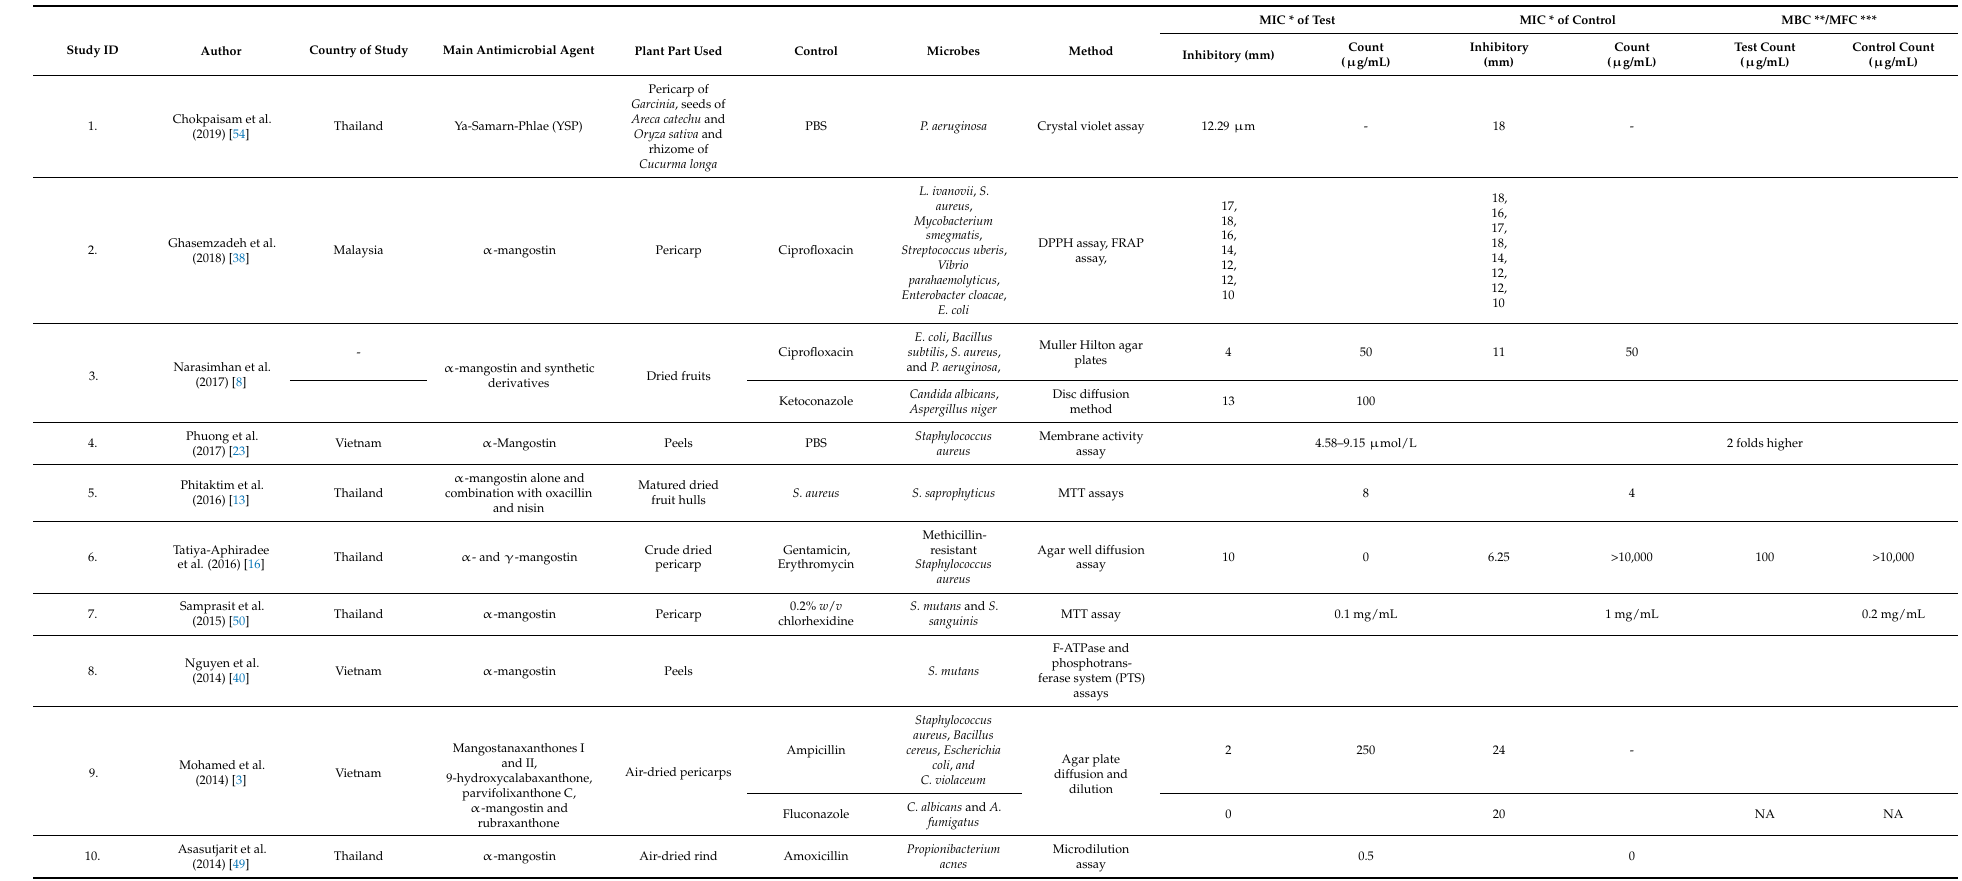
Table 6. Characteristics of the studies and their outcomes and